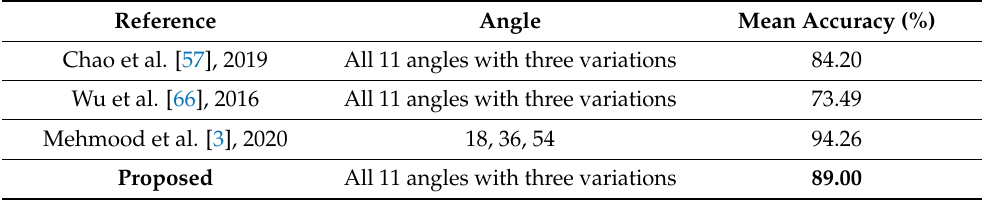
Table 10. Comparison of proposed method with STOA